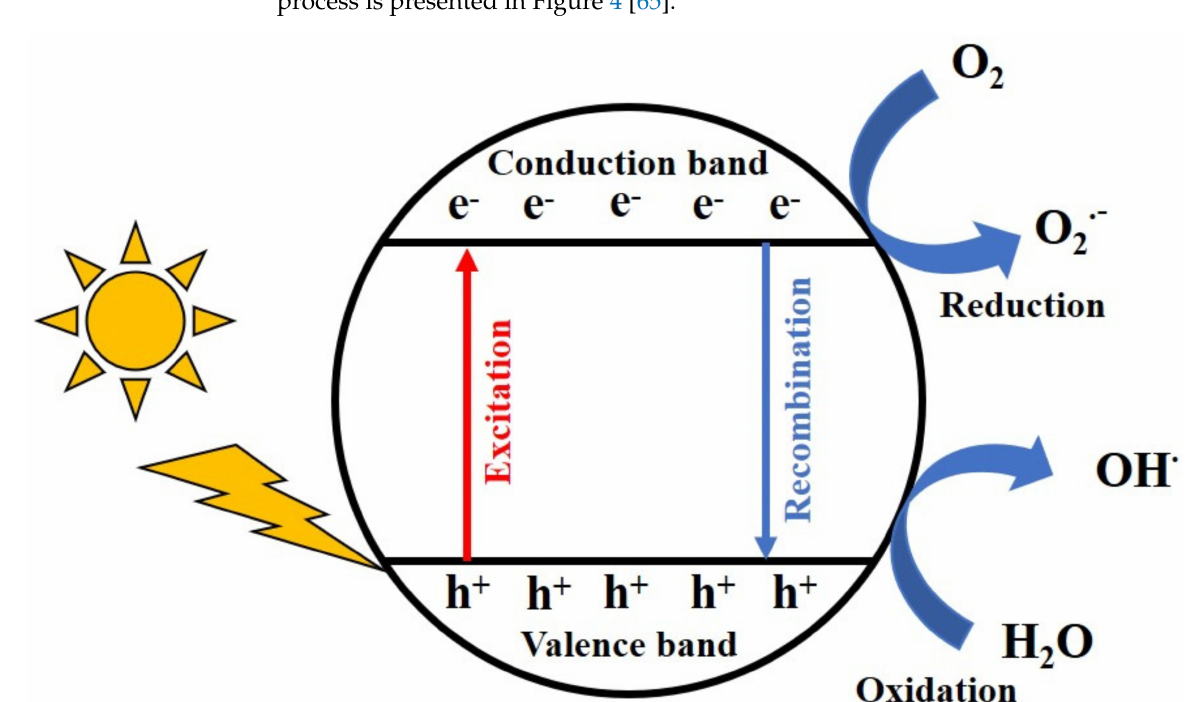
Figure 4. Mechanism for photocatalytic degradation. Reprinted with permission from Ref.